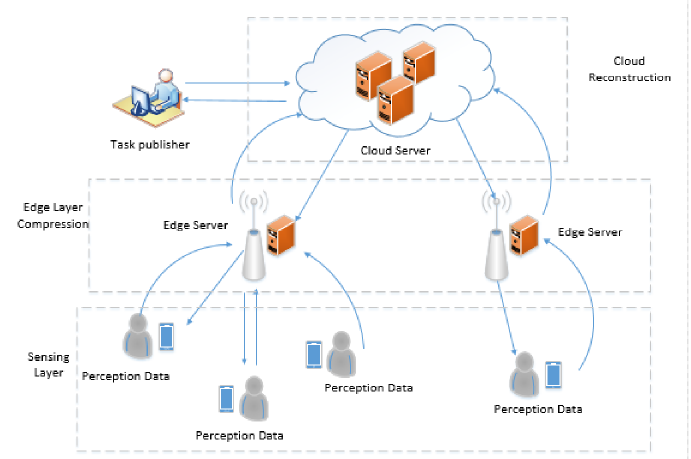
Fig. 1. Data collection model based on edge